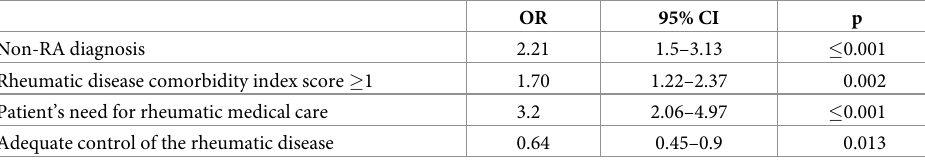
Table 4. Regression analysis to identify factors associated with